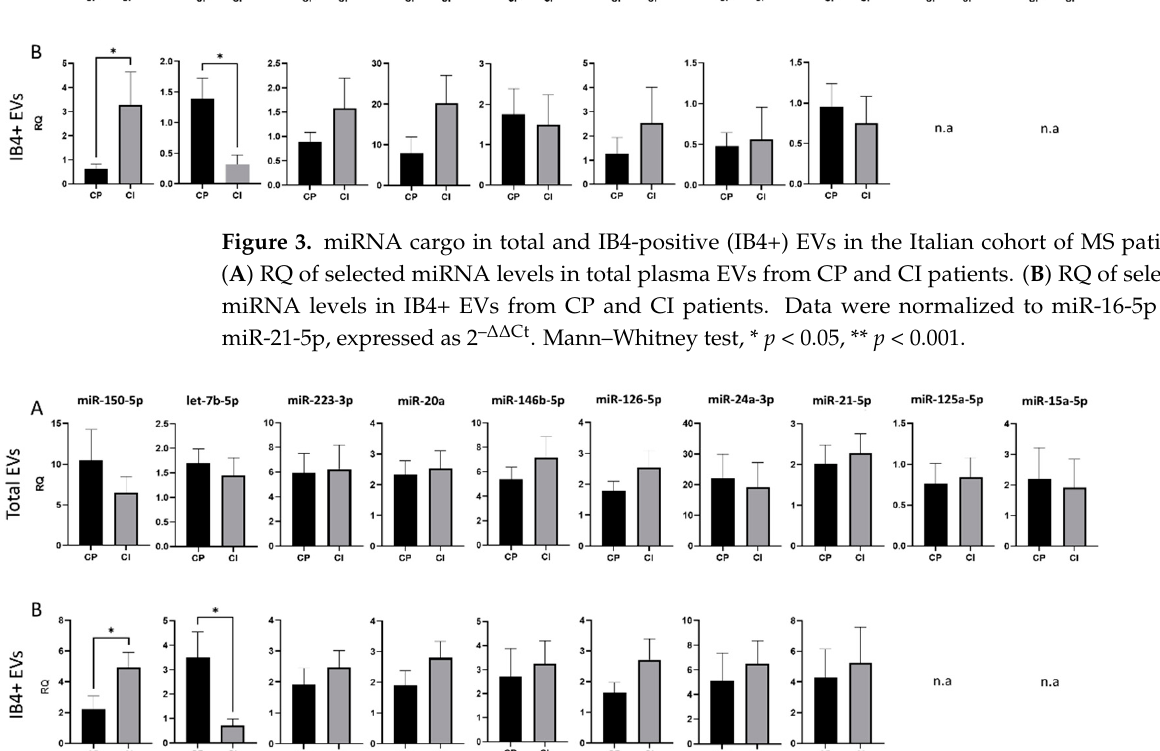
Figure 4. miRNA cargo in total and IB4-positive (IB4+) EVs in the Amsterdam MS Center cohort of MS patients. ( A ) RQ of selected miRNA levels in total plasma EVs from CP and CI patients. ( B ) RQ of selected miRNA levels in IB4+ EVs from CP and CI patients. Data were normalized to miR-16-5p and miR-451a, expressed as 2 – ΔΔ Ct . Mann–Whitney test, * p < 0.05.